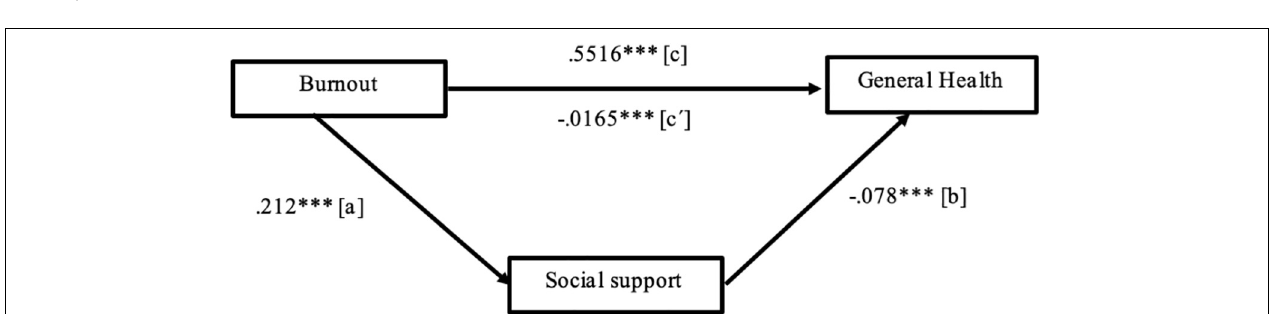
FIGURE 1 | The unstandardized regression coefficients for the mediating effect of social support on the relationship between burnout and health. *** p <